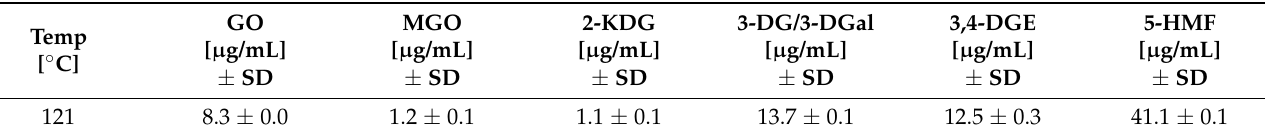
Table 5. Concentrations of GDPs in 10% ( w / v ) glucose solutions in PP bottles heat sterilized at 121 ◦ C for 350 min (F0 = 202 min). 3 batches with 3 bottles each were analyzed ( n = 9).